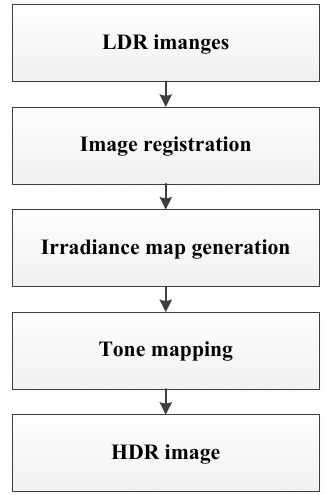
Figure 2. Tone mapping processing chain.